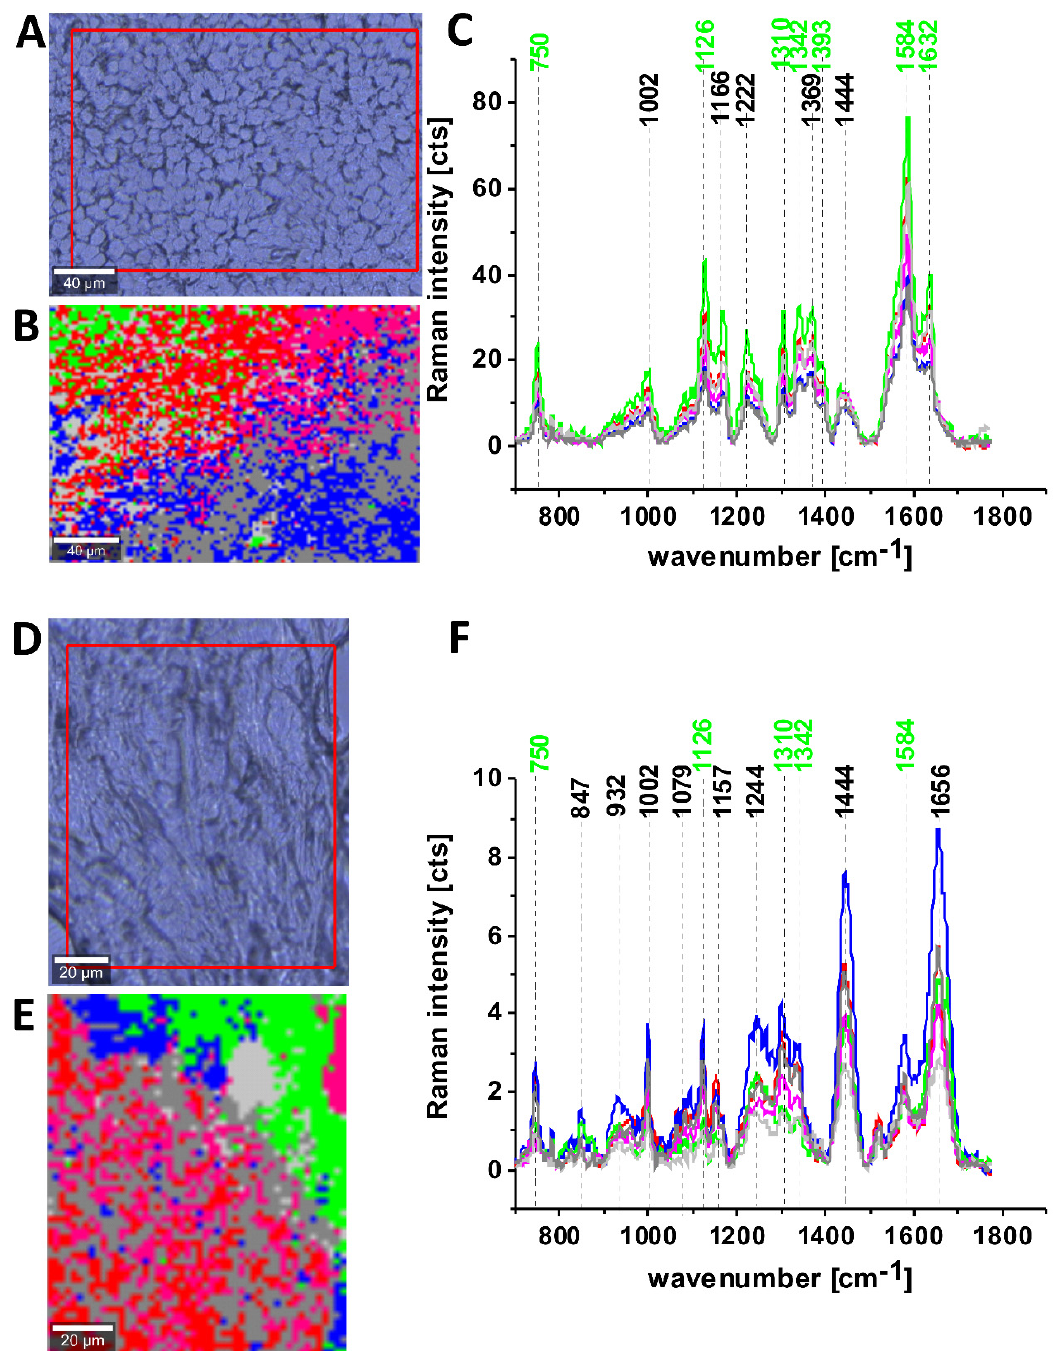
Figure 9. Microscopy image ( A ), Raman image (230 × 160 µ m, resolution 0.5 µ m, integration time 1 s) ( B ), the average Raman spectra of lipids (blue color), proteins (red color), cytochrome (green color), mitochondria – magenta at excitation 532 nm, Anaplastic oligodendroglioma (G3) ( C ) Microscopy image ( D ), Raman image (100 × 120 µ m, resolution 0.5 µ m, integration time 1 s) ( E ), the average Raman spectra of lipids (blue color), proteins (red color), cytochrome (green color), mitochondria (magenta color) at excitation 532 nm, meningioma (G2) ( F ).